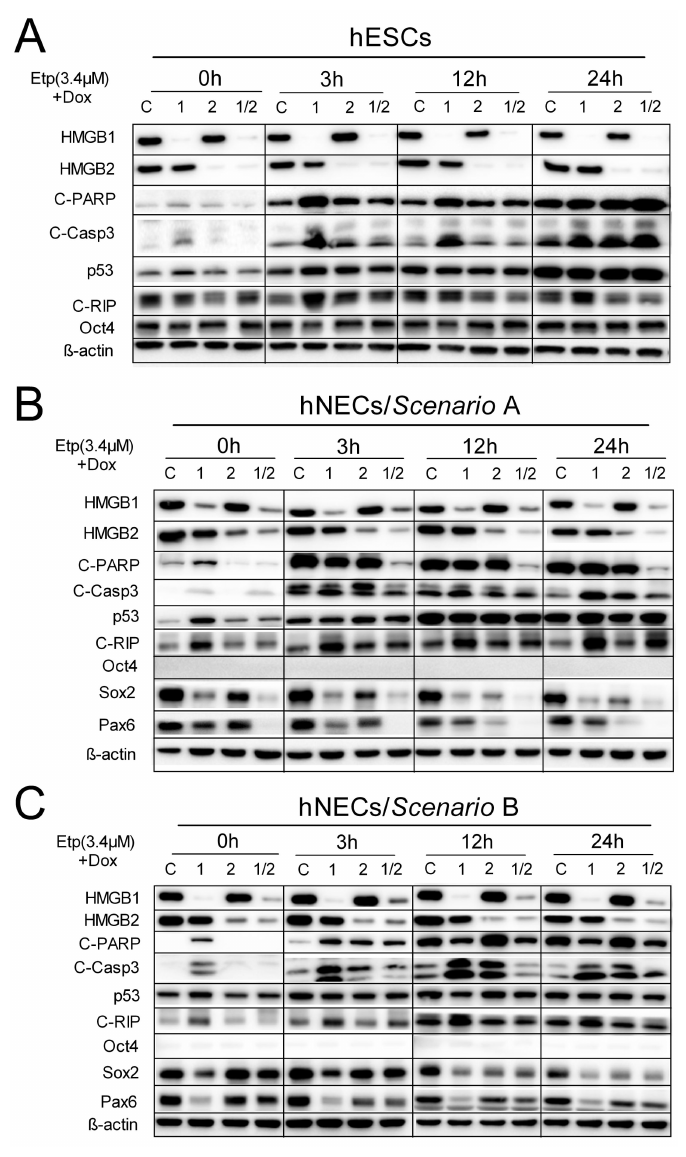
Figure 7. HMGB1 and HMGB2 di ff erentially a ff ect Casp3 / PARP cleavage in etoposide-treated hESCs or hNECs. ( A-C ) Western blotting of total cellular lysates from hESCs and hNECs prepared by Scenario A or B. Equal loading of samples was verified using anti- β -actin antibody. “C”, cells transfected with empty vector; “1”, cells upon HMGB1 knockdown; “2”, cells upon HMGB2 knockdown; “1 / 2”, cells upon HMGB1 and HMGB2 knockdown. C-Casp3, cleaved caspase-3; C-PARP, cleaved PARP (poly (ADP-ribose) polymerase); C-RIP, cleaved RIP (receptor-interacting protein kinase). 3.8. Impact of HMGB1 / 2 KD on Telomere Integrity is Distinct in Etoposide-Treated hESCs and